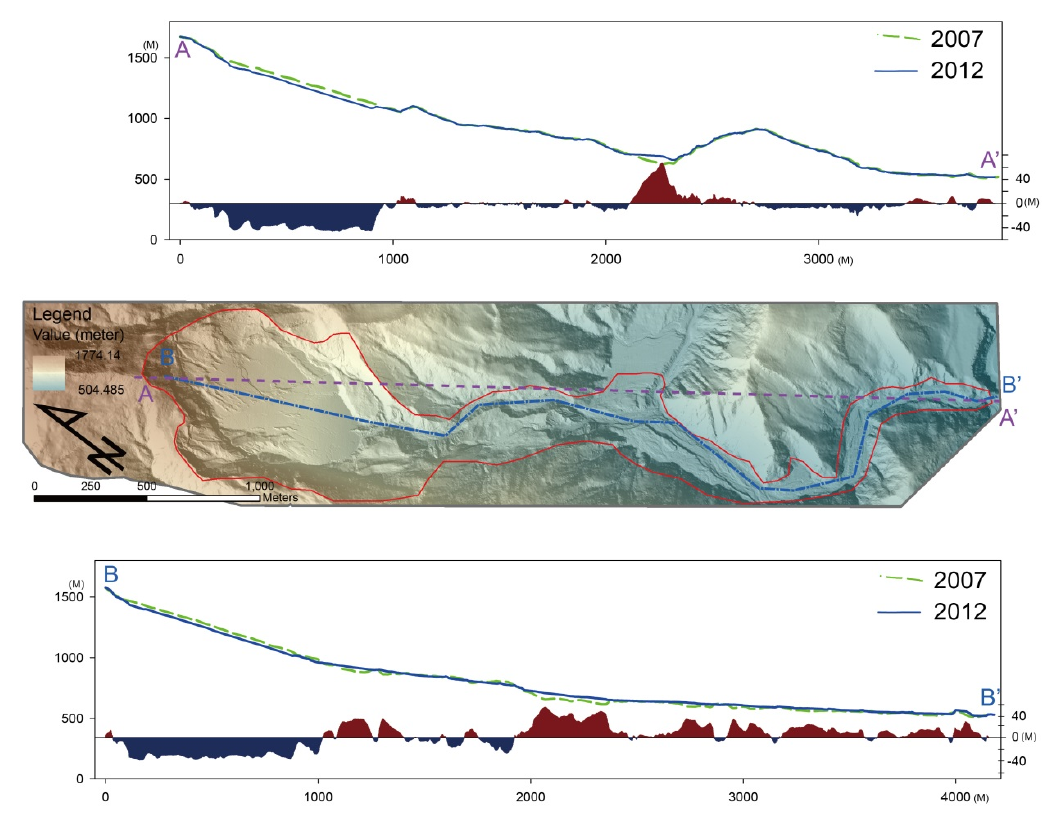
Figure 7. Straight line and polyline profiles based on terrain data obtained in 2007 ( before landslide ) and 2012 ( after landslide ). The purple A–A’ dashed section shown in the middle represents the straight line profile, whose results are shown in the top; the blue B–B’ section in the middle represents the polyline profile, whose results are shown in the bottom. The bottoms of the profile subfigures illustrate the elevation changes during 2007–2012, where dark blue denotes elevation decrease, while dark red denotes elevation increase.